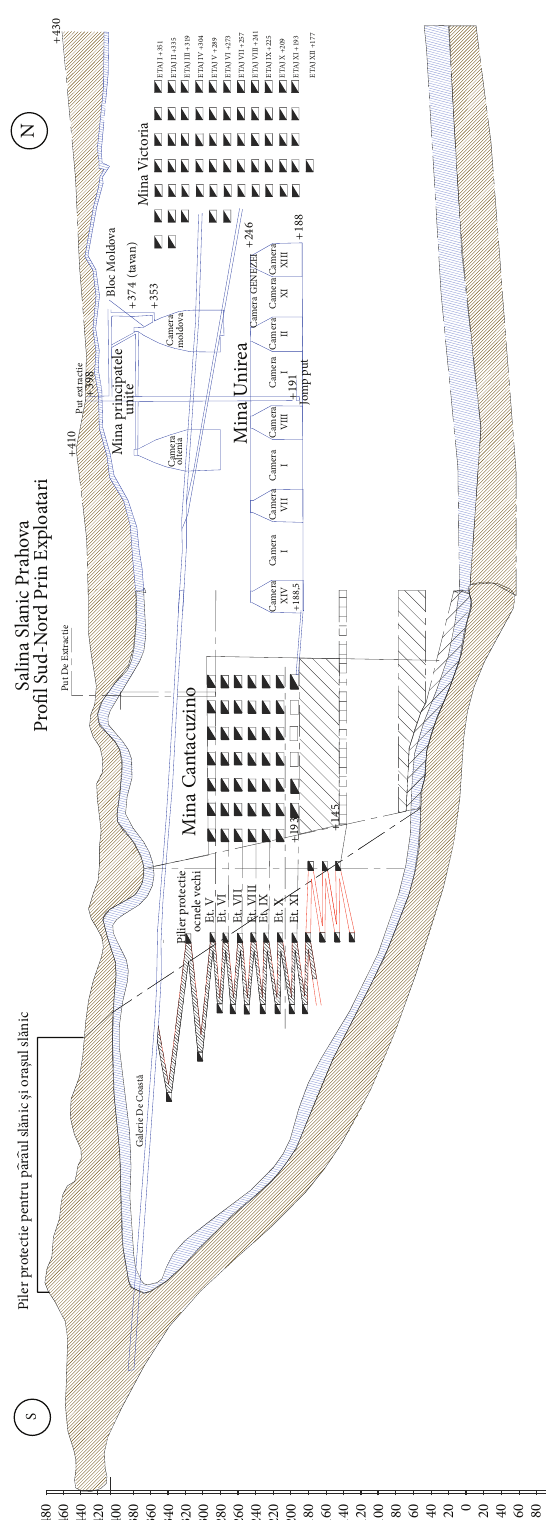
Figure 1: Artistic view of the salt ore of